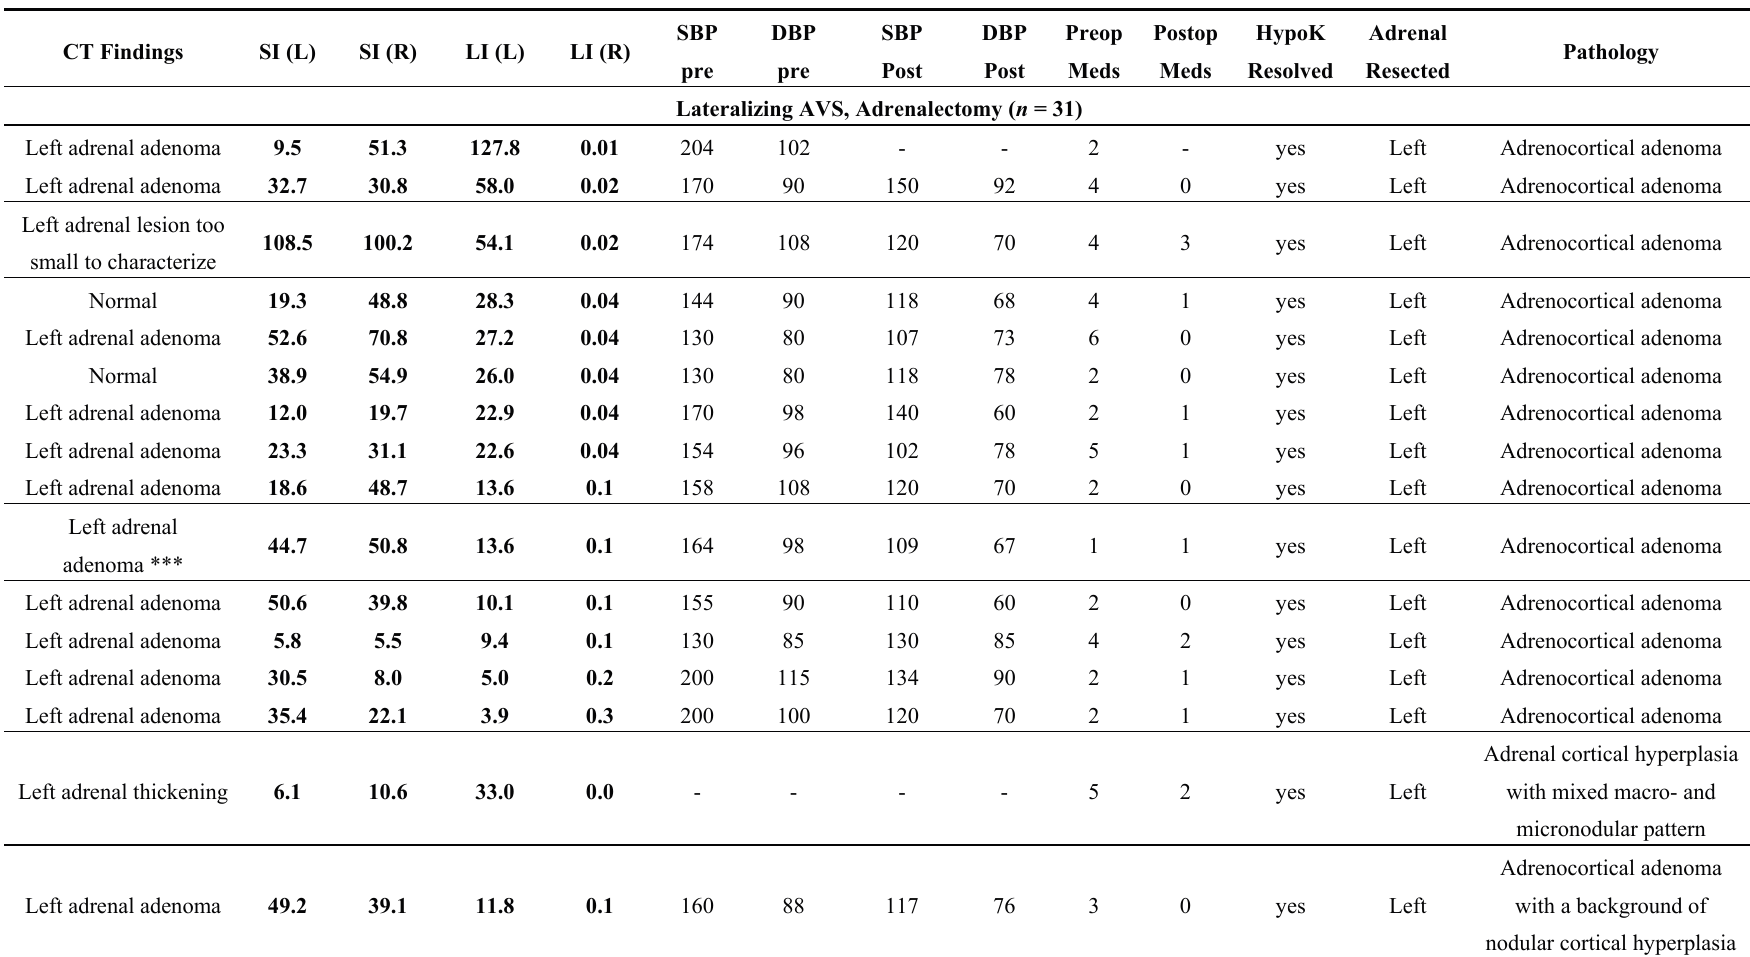
Table 2. AVS, pathologic, imaging and clinical data for all patients. SI: sensitivity index; LI: lateralization index; SBP: systolic blood pressure; DBP: diastolic blood pressure; HypoK: hypokalemia; Preop: pre-adrenalectomy; Postop: post-adrenalectomy; meds: blood pressure medications. Hypokalemia was considered resolved in potassium levels increased from a value below normal to a value within normal range or higher (normal range 3.5–5.0 mEq/L). *** indicates patients who underwent repeated